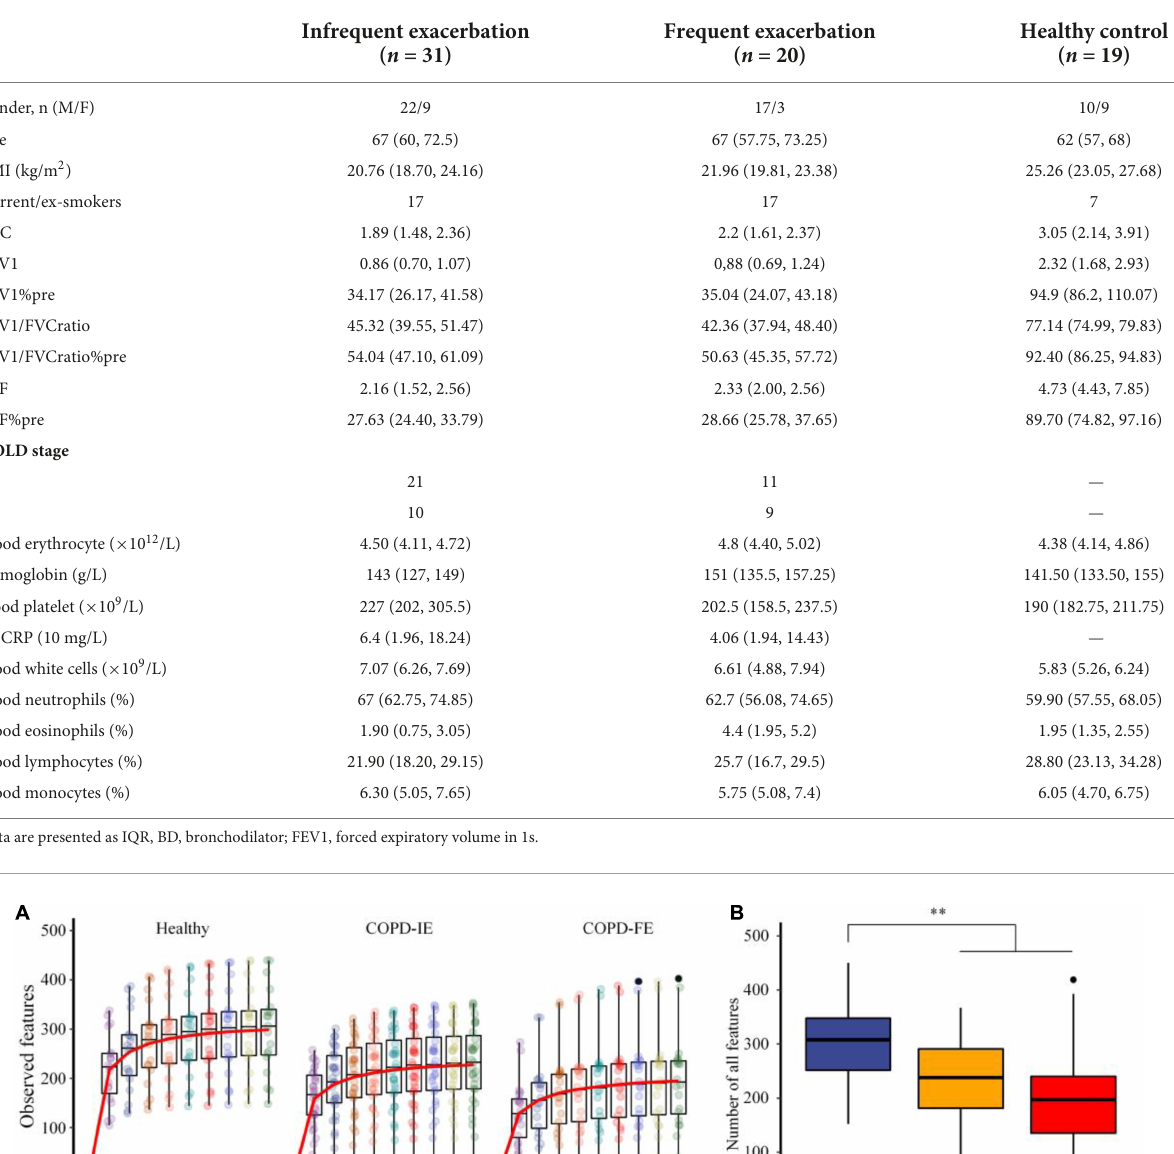
TABLE 1 Characteristics of the study population.